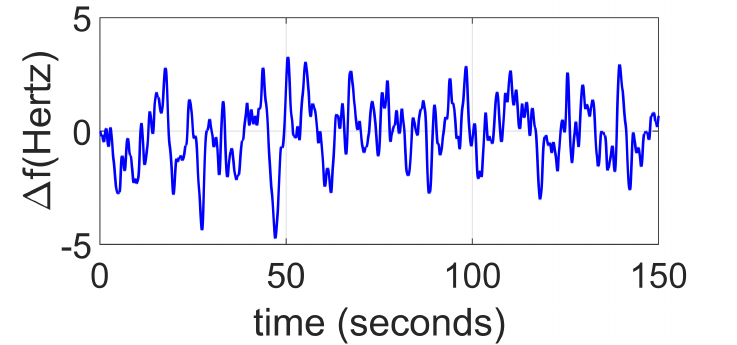
Figure 6. Frequency measurement under random